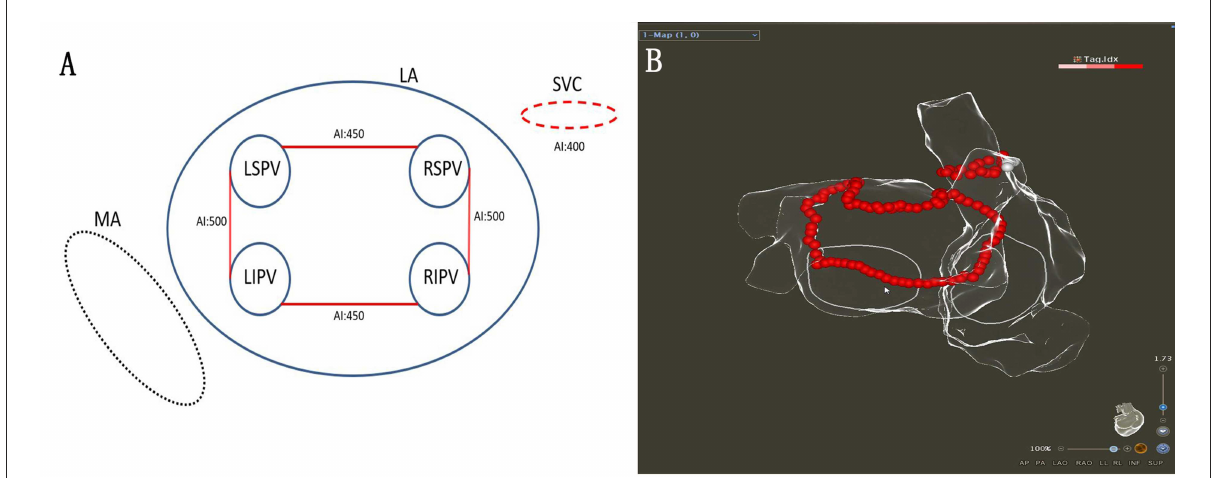
FIGURE1 (A,B) Schematic figure of ablation strategy used in this study.